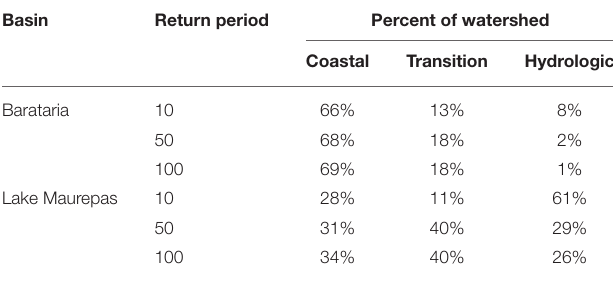
TABLE 3 | Percent of watershed made up of each flood zone type (coastal, transition, and hydrologic). Basin Return period Percent of watershed